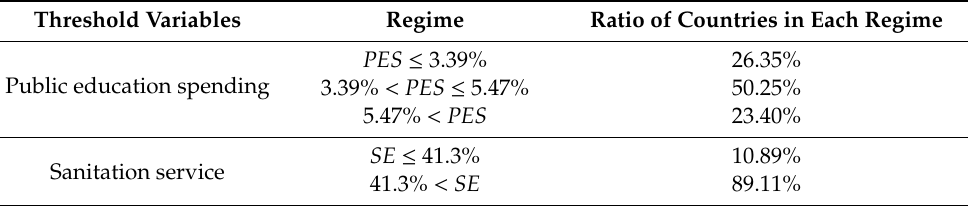
Table 11. Proportion of countries in each threshold variable